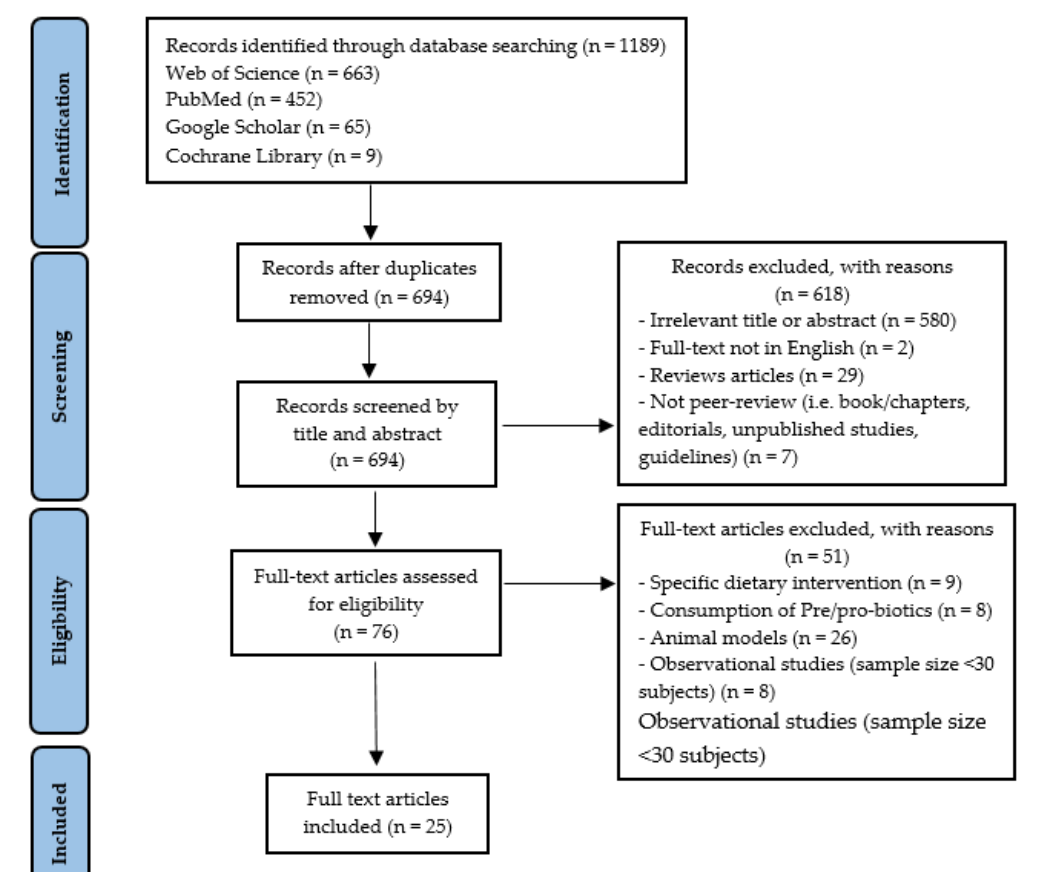
Figure 1. Study selection and eligibility screening flow according to PRISMA guidelines.